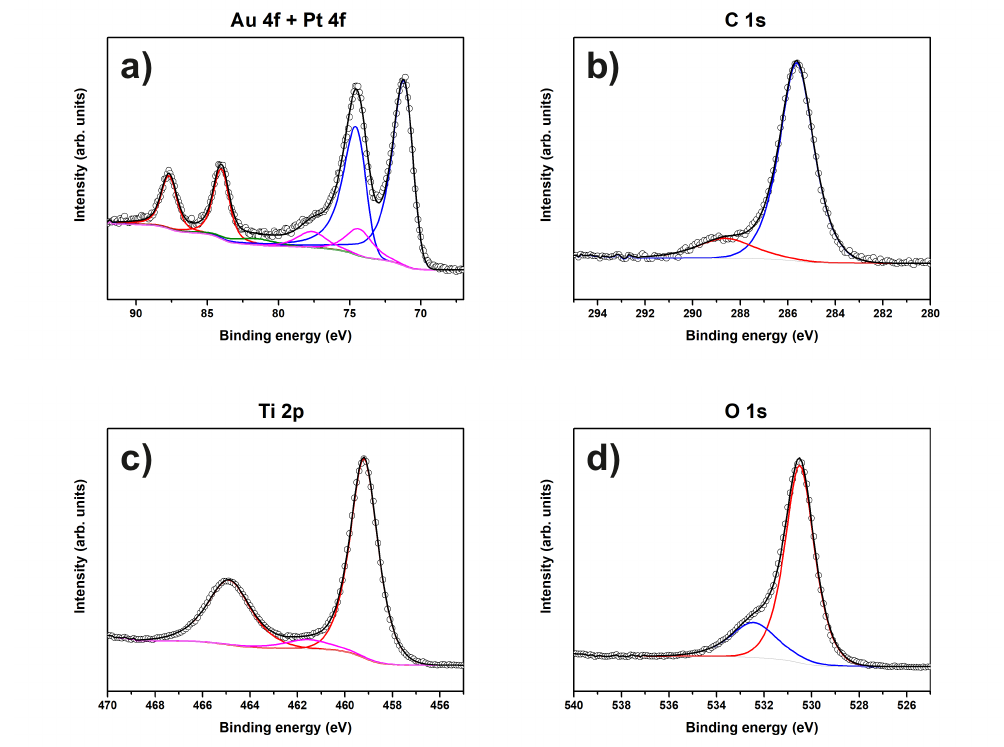
Figure 8. XP spectra of sample “Au/Pt”. The peaks of ( a ) Au 4f and Pt 4f, ( b ) C 1s, ( c ) Ti 2p and ( d ) O 1s and corresponding fits are